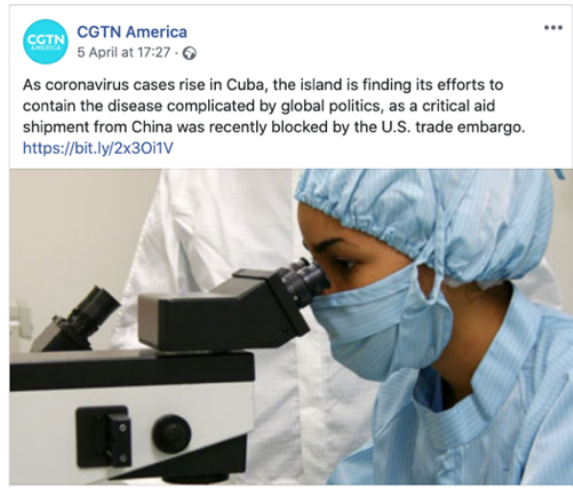
Figure 4. Screenshot of @cgtnamerica’s Facebook post. Source: CGTN America (2020).